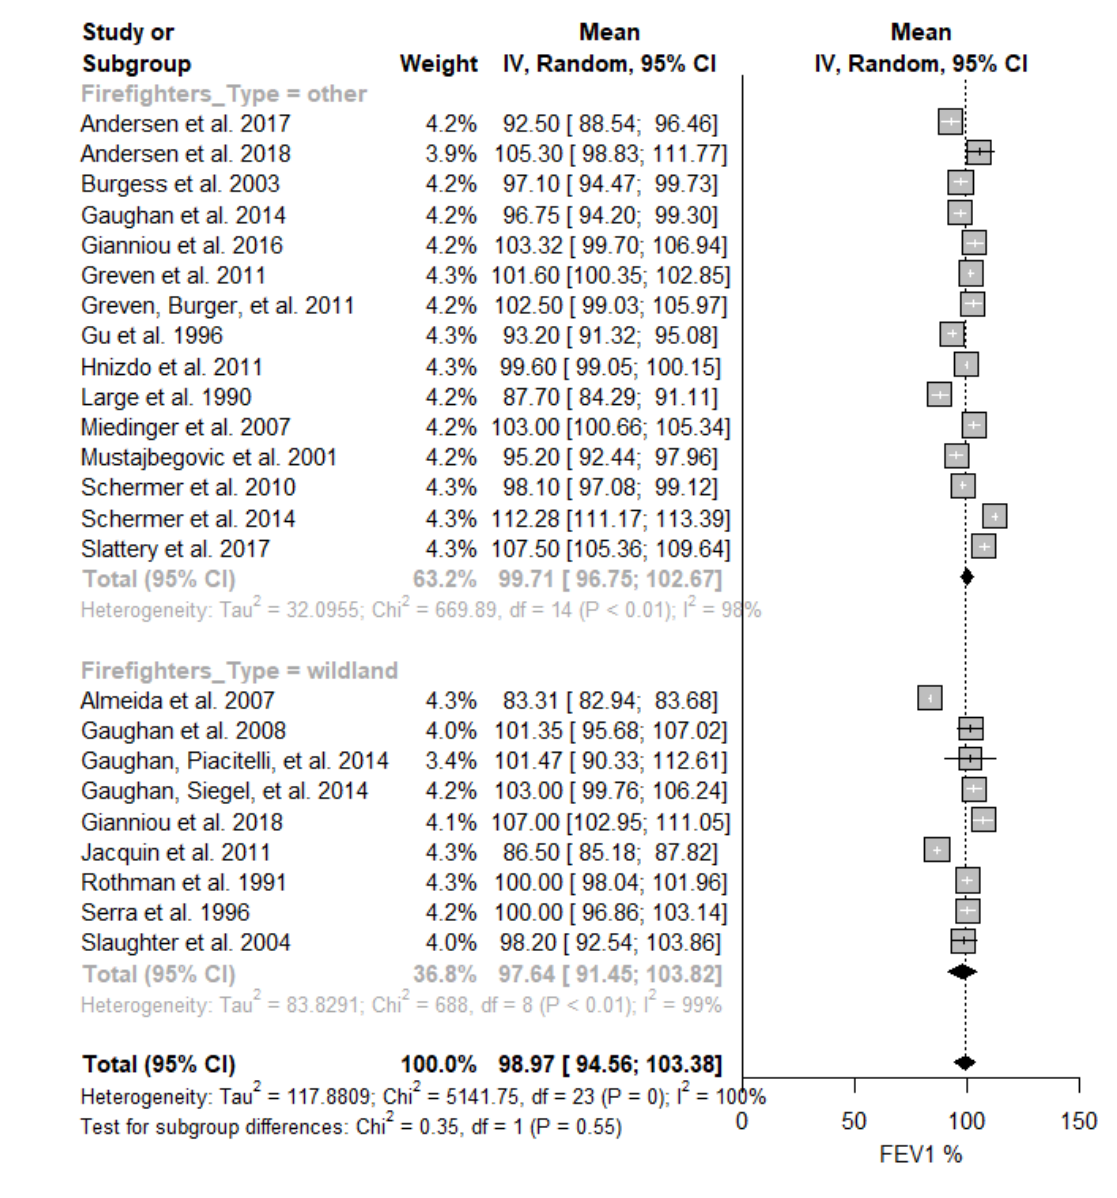
Figure 6. Predicted FEV 1 in firefighters stratified by fire type. Forest plot displaying the weight of the predicted FEV 1 mean value and heterogeneity [13,40–62].